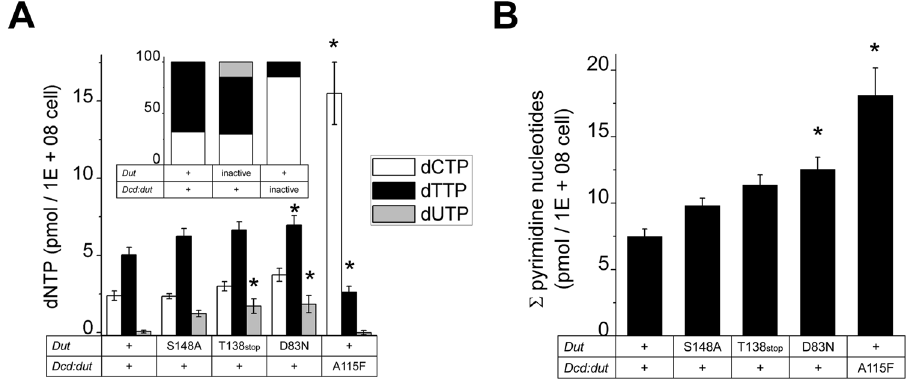
Figure 6. The effect of dut and dcd:dut mutations on the pyrimidine nucleotide pool. ( A ) dTTP, dCTP and dUTP concentrations were measured using a DNA polymerase-based method in all mutant strains. Mutant enzymes are indicated, “ + ” denote the wt enzyme. Means ± SE are calculated from 12 data points for each mutation. The dUTP concentration in the wt and in the A115F mutant falls out of the measurement range ( < 0.5 pmol/108 cells). Significance levels: P = 0.063 for the T138stop dUTP level, P = 0.095 for the D83N dTTP level, P = 0.047 for the D83N dUTP level, P = 0.000012 for the A115F dCTP level, P = 0.066 for the A115F dTTP level. The inset shows a comparison of the ratios of pyrimidine nucleotides within the wt and inactive mutant strains. ( B ) The change in total pyrimidine concentration in function of the mutation carried by each strain. Means ± SE are plotted. Significance levels: P = 0.05959 for D83N and P = 0.0028 for